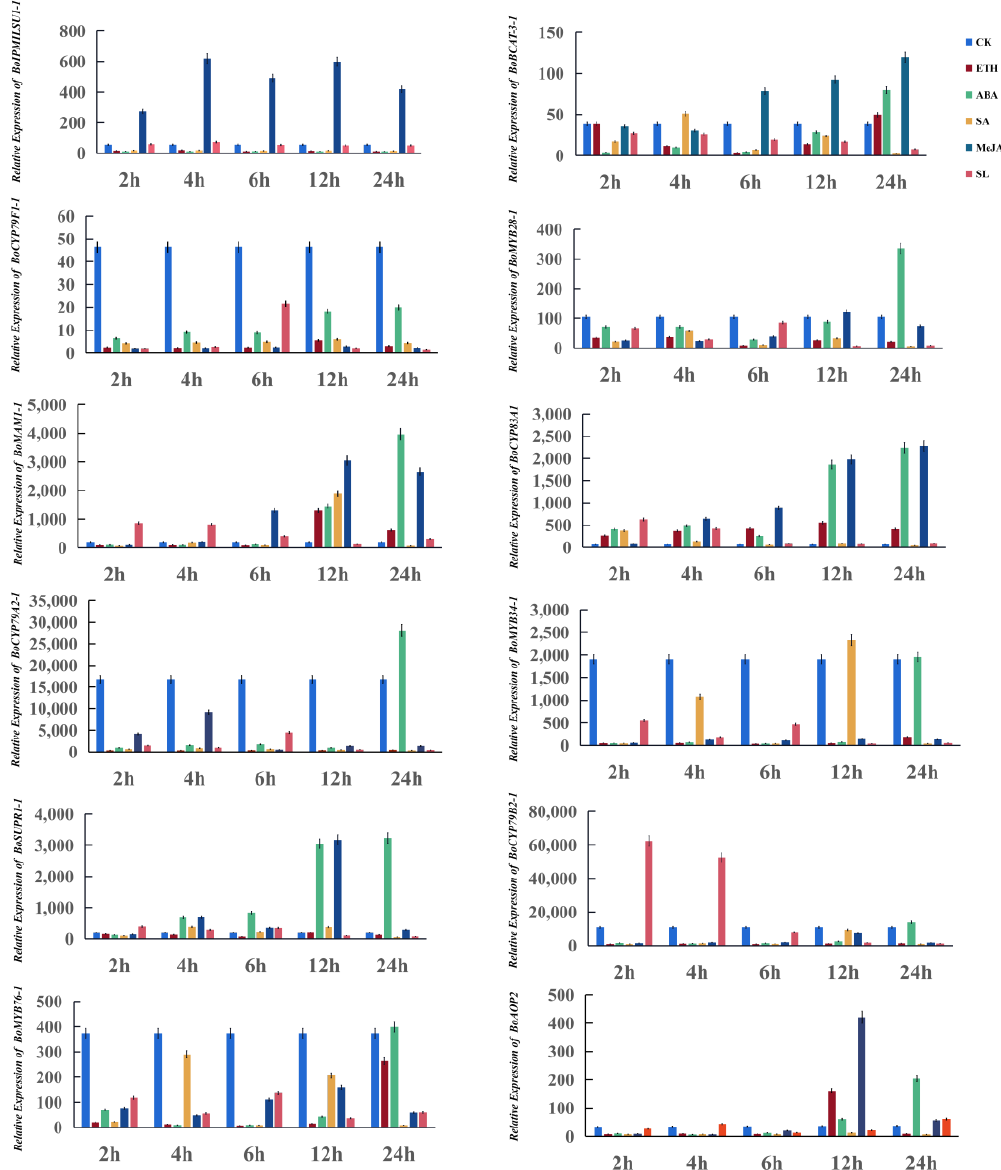
Figure 7. The expression of glucosinolate biosynthetic genes after treatment with exogenous phyto- hormones. The Y and X axes represent the relative expression level and time course of exogenous phytohormone treatment, respectively. Leaves were sampled 2, 4, 6, 12, and 24 h after H 2 O(CK), ethylene (ETH), abscisic acid (ABA), salicylic acid (SA), strigolactone (SL), and methyl jasmonate (MeJA) application. The values represent the mean ± SD of three technical replications.